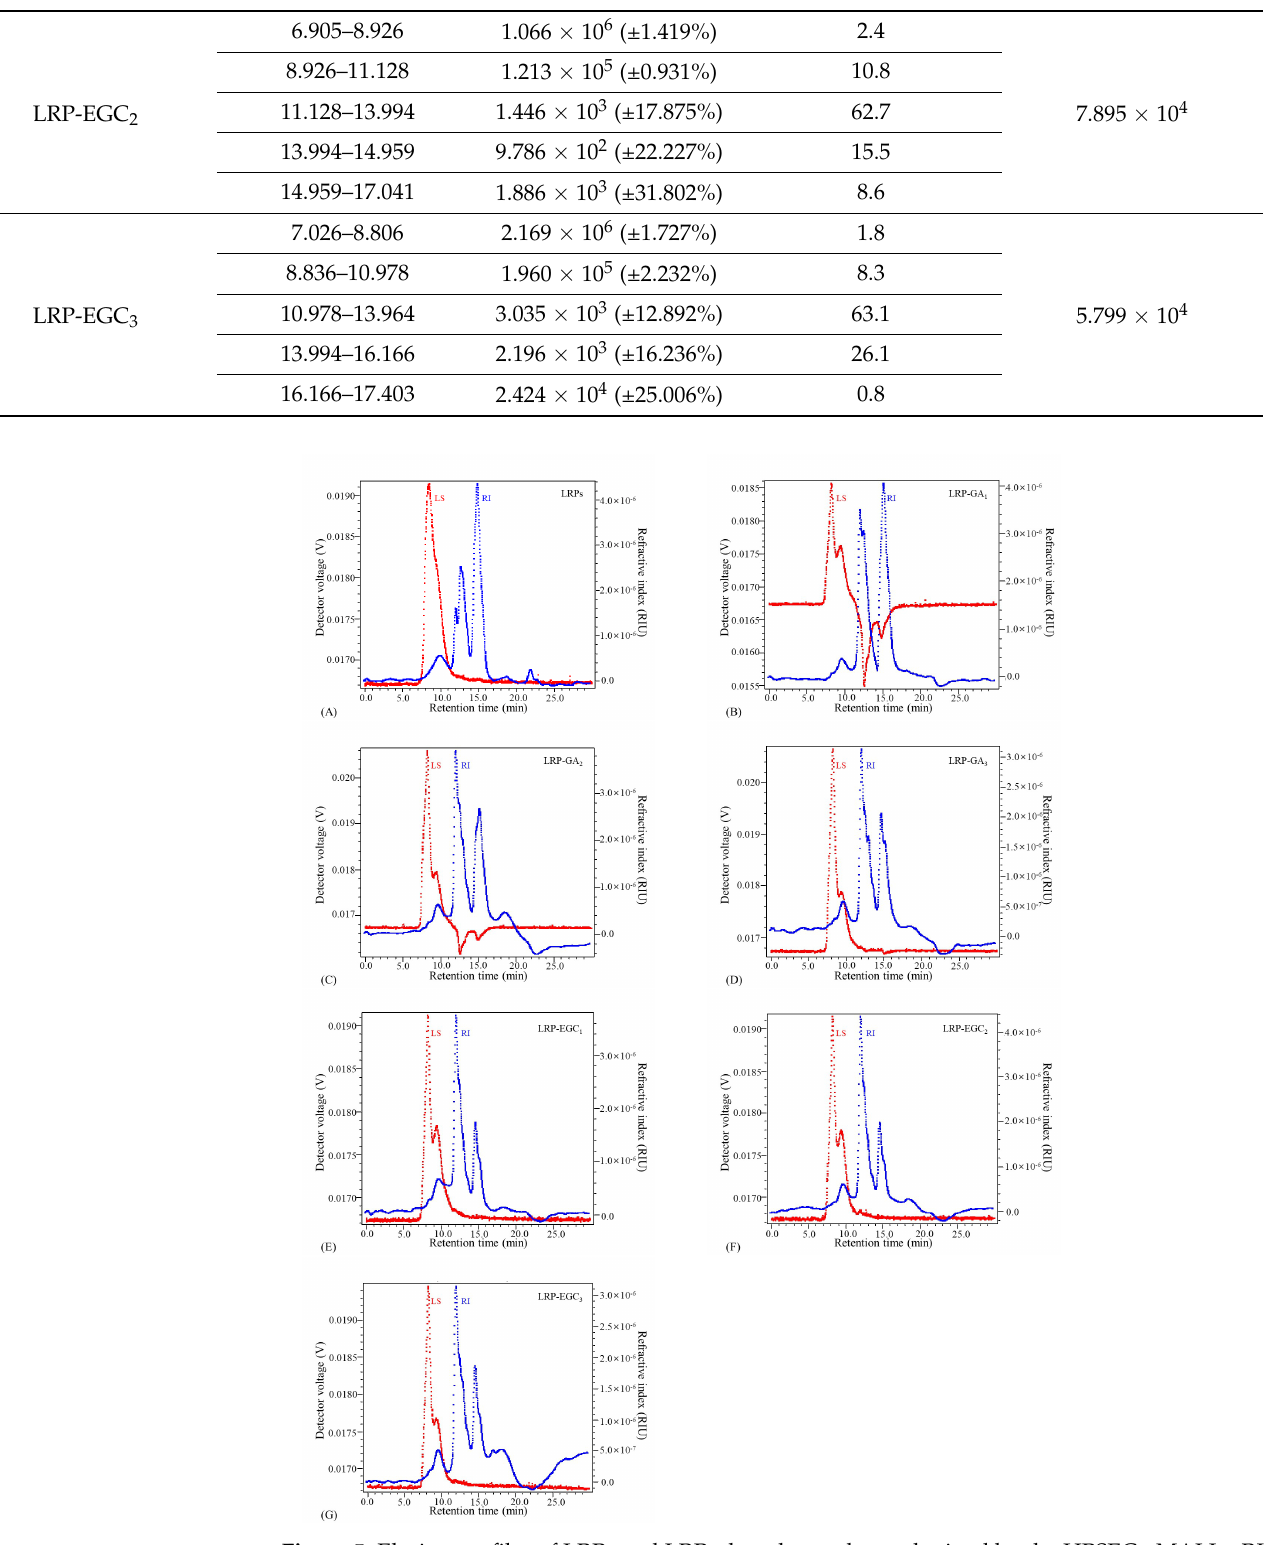
Figure 5. Elution profiles of LRPs and LRP-phenol complexes obtained by the HPSEC − MALL − RI method. LRPs(A);LRP-GA 1 (B); LRP-GA 2 (C); LRP-GA 3 (D); LRP-EGC 1 (E); LRP-EGC 2 (F); LRP- EGC 3 (G). Dotted line in blue presents the refractive index (RI) intensity, dotted line in red presents the light scattering (LS)